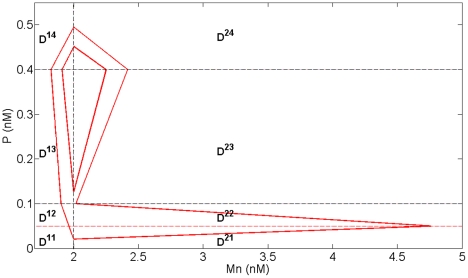
Phase portrait of birhythmicity for Model 3.Simulation of the two oscillatory regimes in the phase space for Model 3. The dashed lines represent the thresholds KMc, KMn and K for P, KP for Mn. The parameter values are the same as for Figure 6 (KMn = 0.1 nM) except KMc = 0.4 nM, K = 0.05 nM, KP = 2 nM, dP = 3 h−1, Mc11 = Mc21 = Mc12 = 0, Mc22 = 5 nM, Mc13 = 9 nM, Mc23 = 11.3 nM, Mc14 =  Mc24 = 25 nM. Note that, since the degradation constants dMn and dP have the same values, the trajectories in each domain are straight lines.